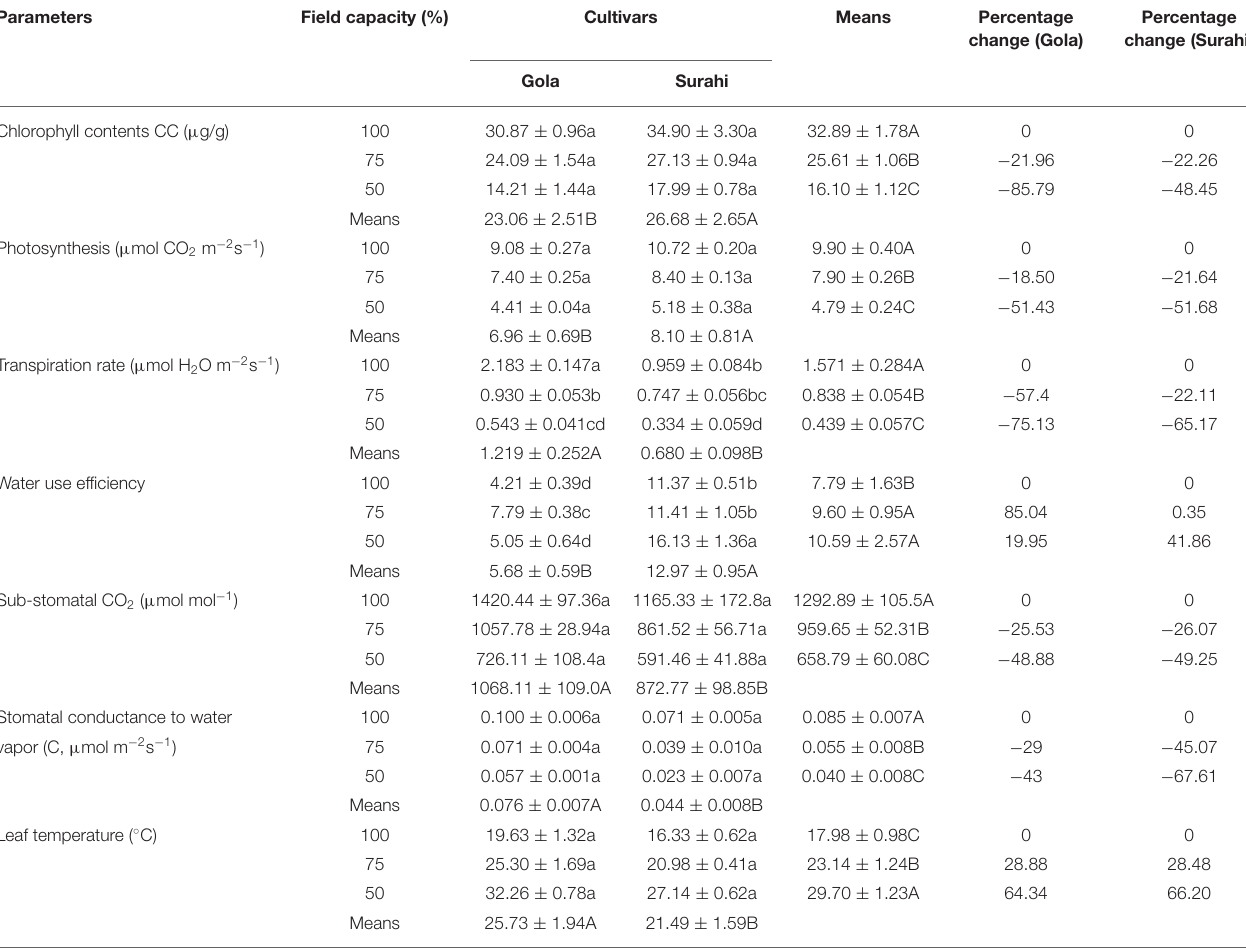
Values are Means ± SE. Small letters represent comparison among interaction means and capital letters are used for overall means. Different letters indicate significance at P > 0.05. Percentage (%) Change = [(value under 75 or 50% Field Capacity – Value under 100% Field Capacity)/Value under 100% Field Capacity] * 100.